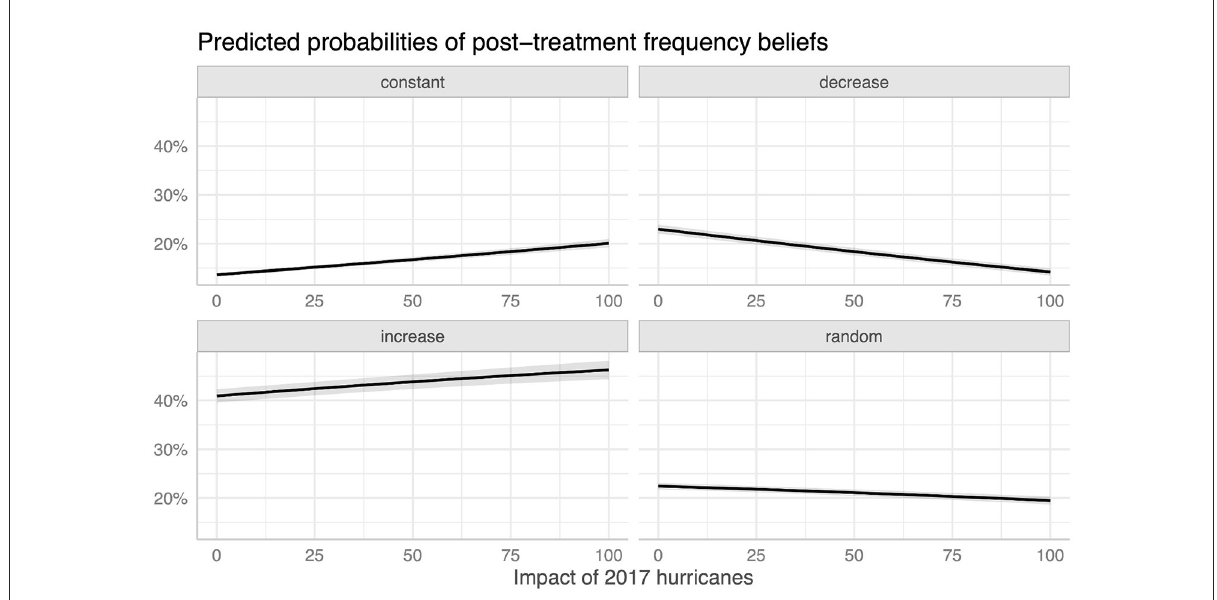
FIGURE4 Plot of predicted probabilities of post–treatment frequency beliefs for self-assessed severity of the impact of 2017 hurricane season.